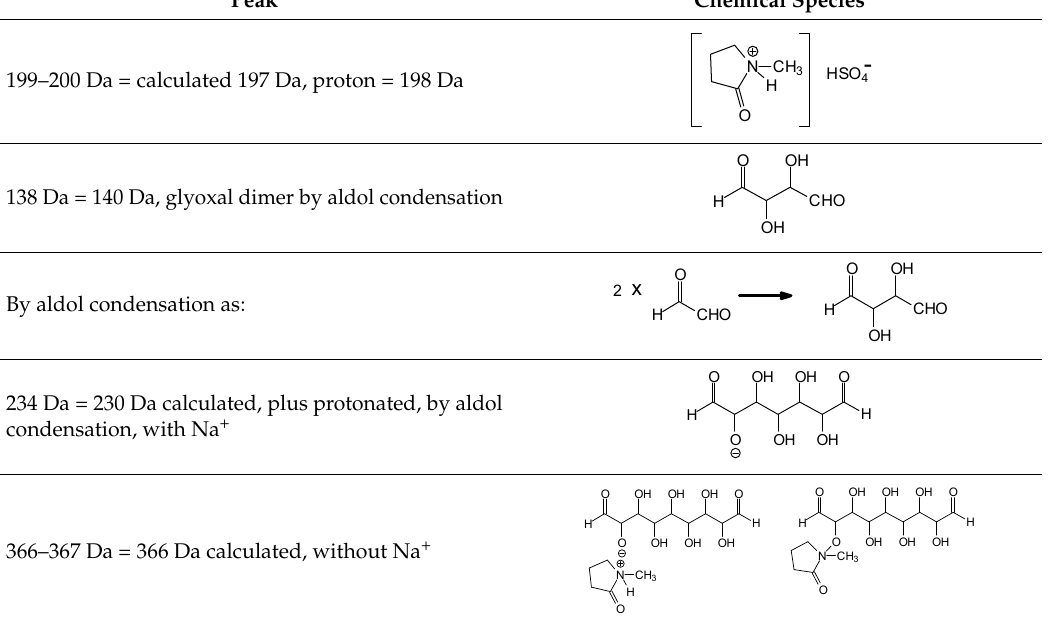
Figure 4. MALDI-ToF spectrum of the interaction between glutaraldehyde and N -methyl-2- pyrrolydone hydrogen sulphate ([HNMP] HSO 4 − ) ionic liquid: ( a ) 20–200 Da range. ( b ) 200–500 Da range. ( c ) 500–900 Da range. Table 3. Species formed by the reaction of glyoxal with IL, by MALDI. Peak